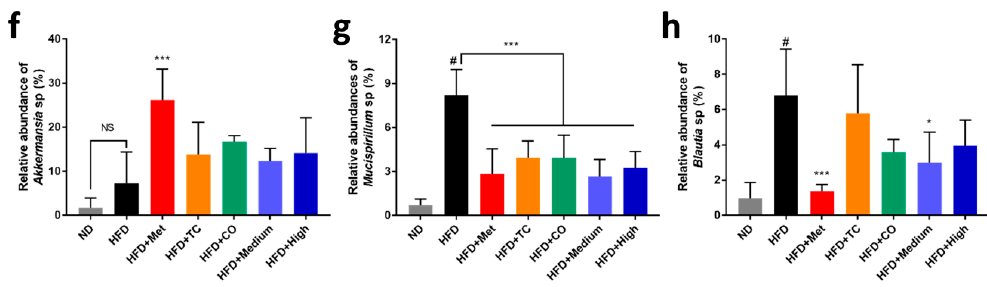
Figure 4. CO / TC formula alters gut microbiota composition in HFD-fed mice (n = 5). Alpha Figure 4. CO/TC formula alters gut microbiota composition in HFD-fed mice (n = 5). Alpha diversity